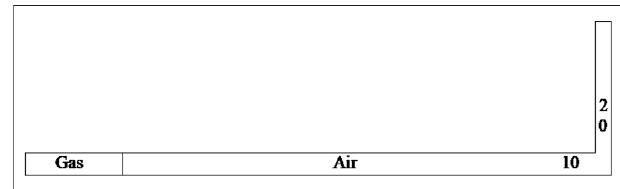
FIGURE 3 | Section diagram of physical